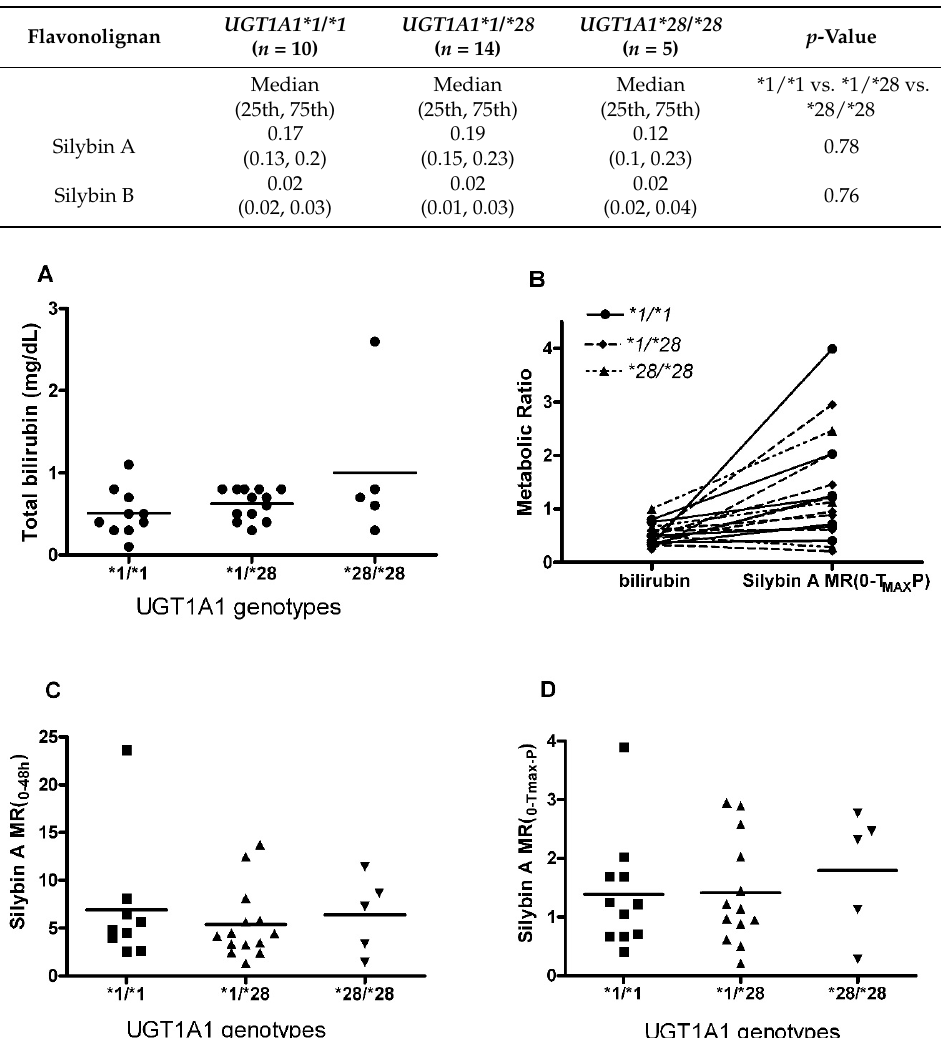
Table 3. Silybin A and Silybin B dose-normalized exposures (AUC (0–48 h) , ng · h/mL · mg) in patients with different UGT1A1 genotypes.